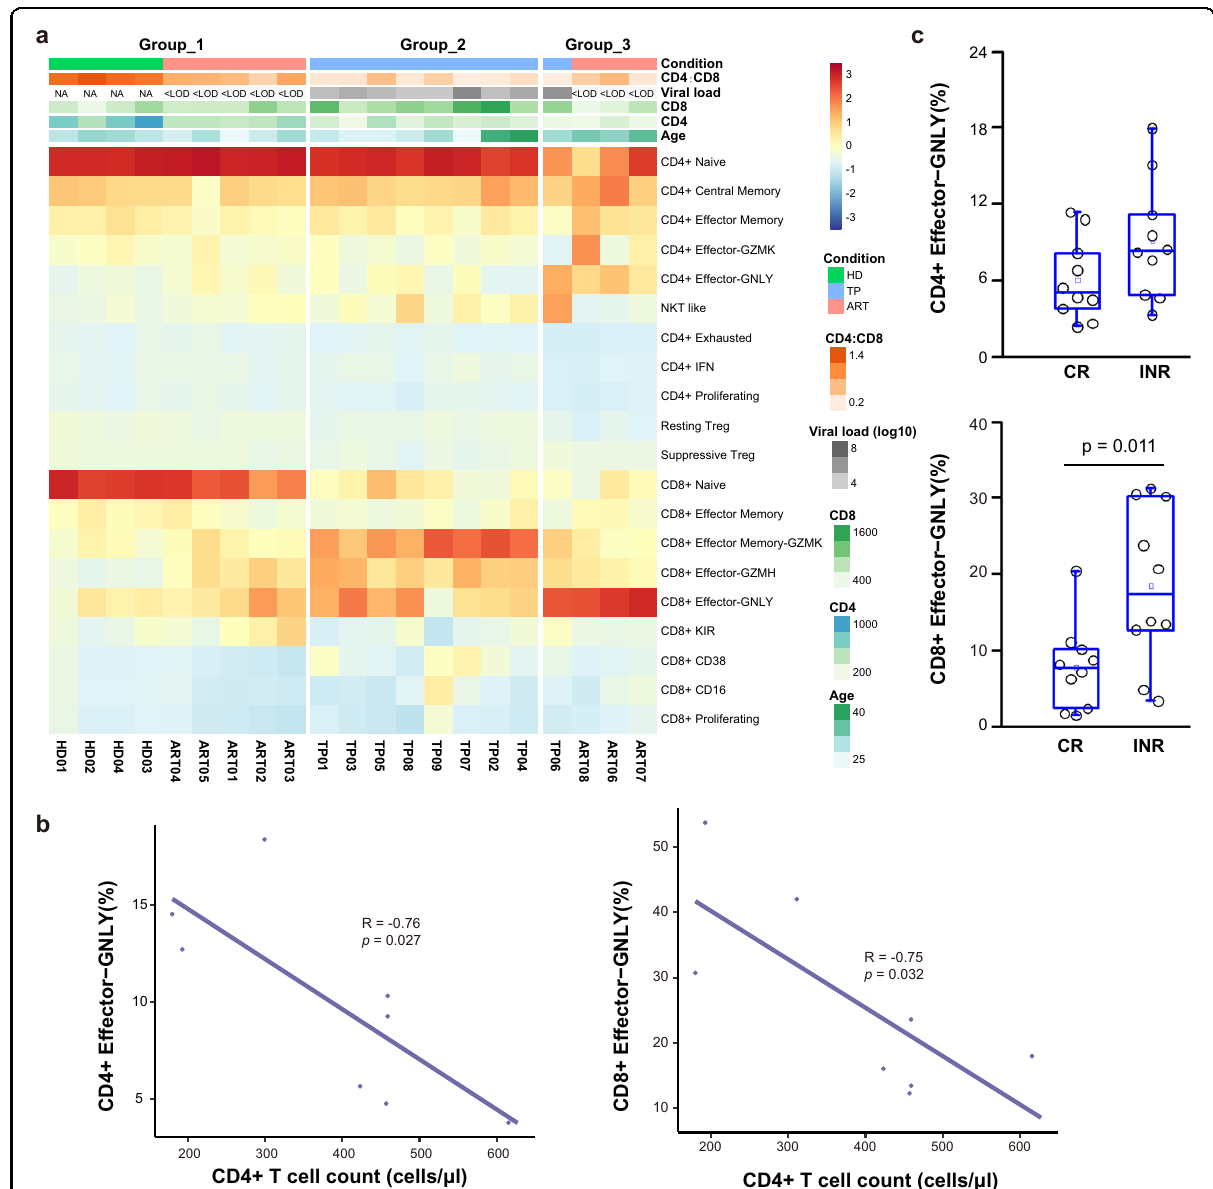
Fig. 6 Clinical implications of GNLY + effector T cells in chronic HIV-1-infected individuals. a Hierarchical clustering of compositions of CD4 +